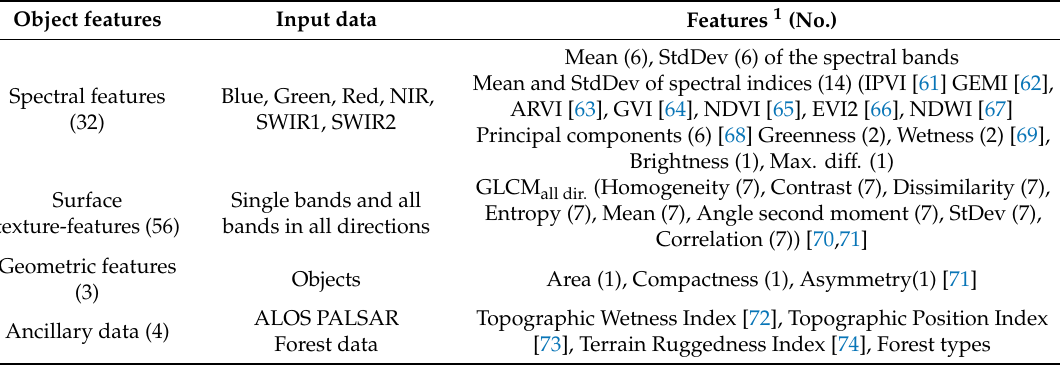
Table 1. Object features derived from Landsat 8 OLI channels and ancillary data (topographic and forest data) for discriminating defoliated forests from healthy forests in NE